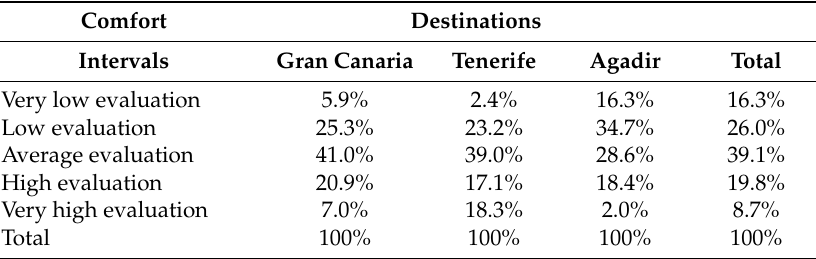
Table 3. Comparative analysis of the comfort variable.